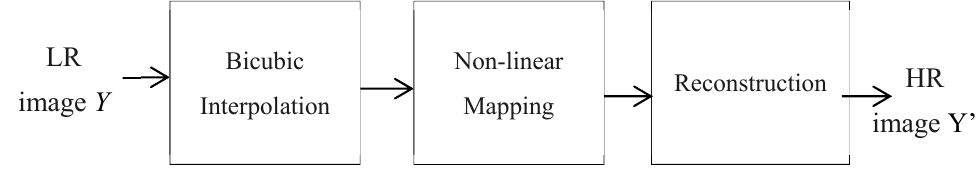
Figure 4. SRCNN Figure 4. SRCNN architecture.